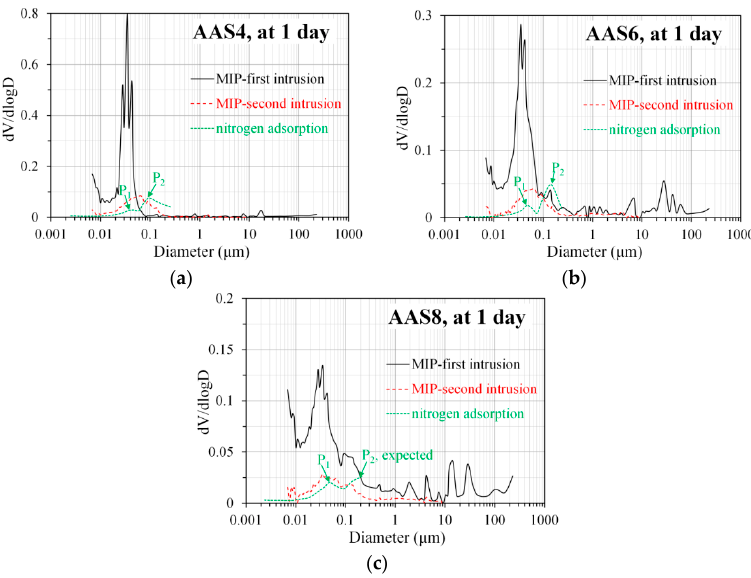
Figure 12. Comparison of the differential curves derived from MIP and N 2 adsorption for AAS4 ( a ), AAS6 ( b ), and AAS8 ( c ) at 1 day. In the graphs, P 1 and P 2 are the first and second peak respectively, AAS indicates alkali-activated slag, and the number following AAS refers to the weight percentage of Na 2 O with respect to slag. For all samples, the water to slag ratio was 0.4 and the curing temperature was 20 °C.